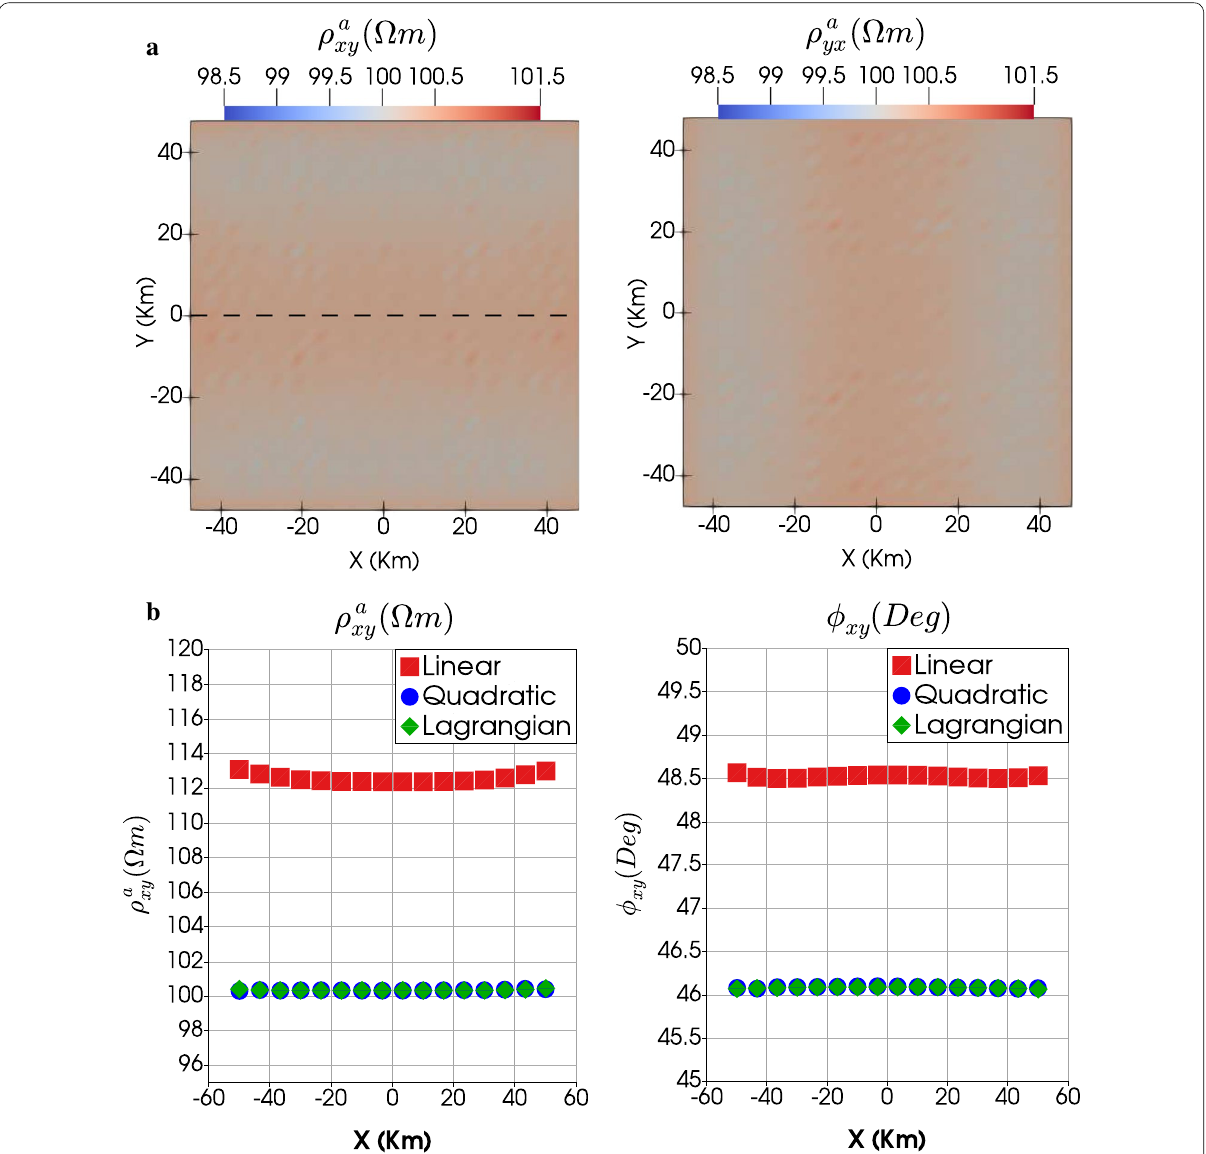
Fig. 5 MT responses obtained from applying GPML‑II boundary conditions (Zhou et al. 2012). a Apparent resistivity at the model surface for xy ‑(left panel) and yx ‑(right panel) polarizations using Lagrangian elements. b Numerical values for apparent resistivity (left panel) and phase angle (right panel) along the profile y ≡ 0 for the xy ‑polarization, shown for all implemented numerical